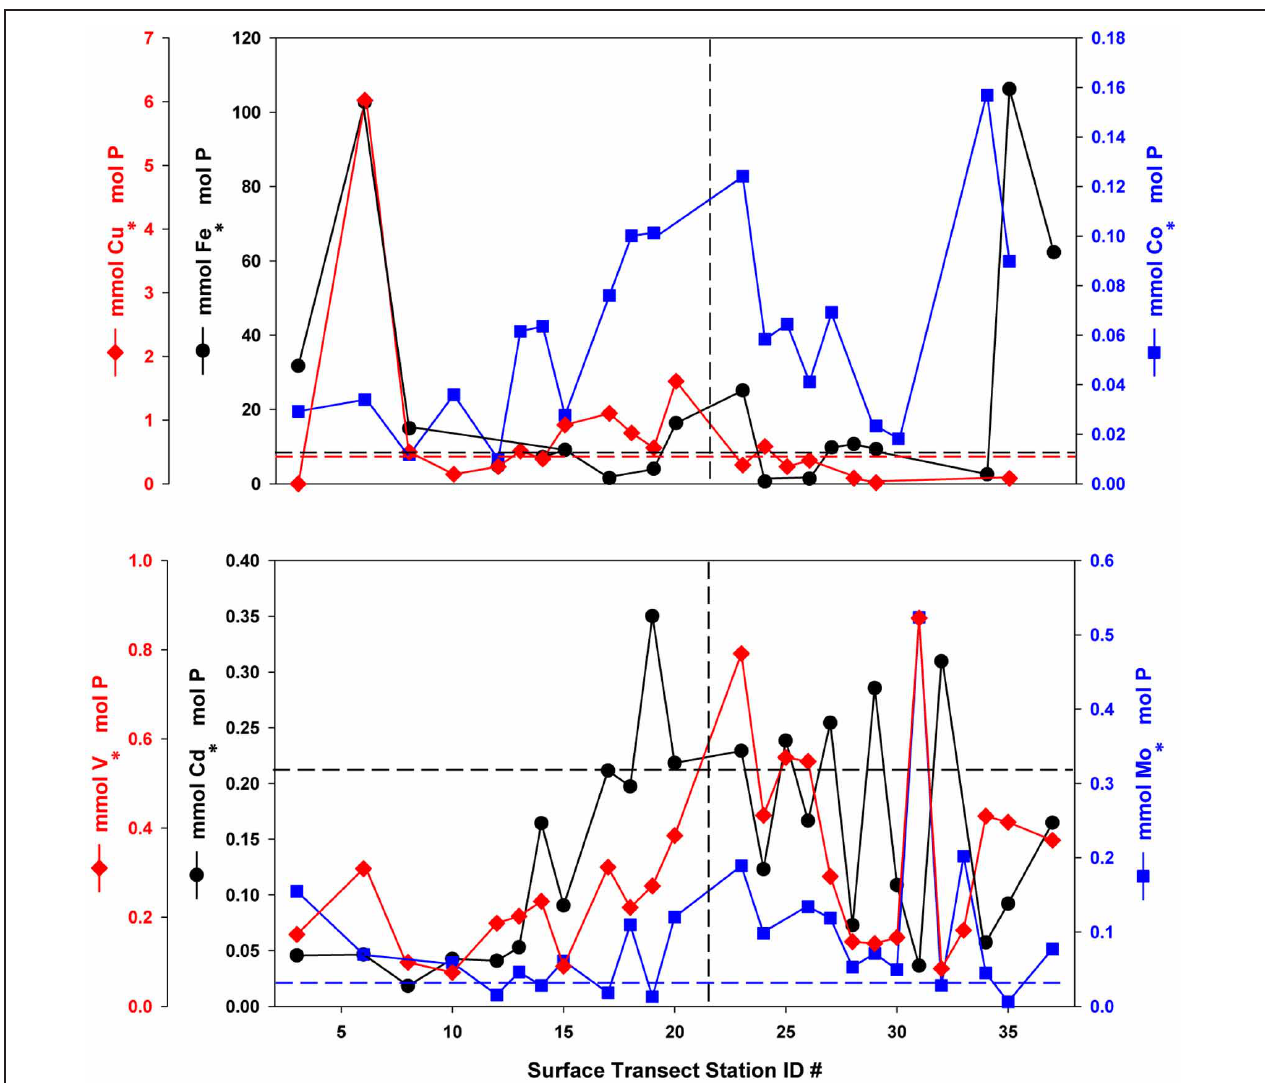
FIGURE 3 | Oxalate-washed P-standardized particulate trace metals along the NASB transect (depth = 10m). Vertical dashed line separates the Southern (left panel, stations 1–23) from Northern (right panel, stations 24–37) transect sections. Horizontal dashed lines are color-coded by element